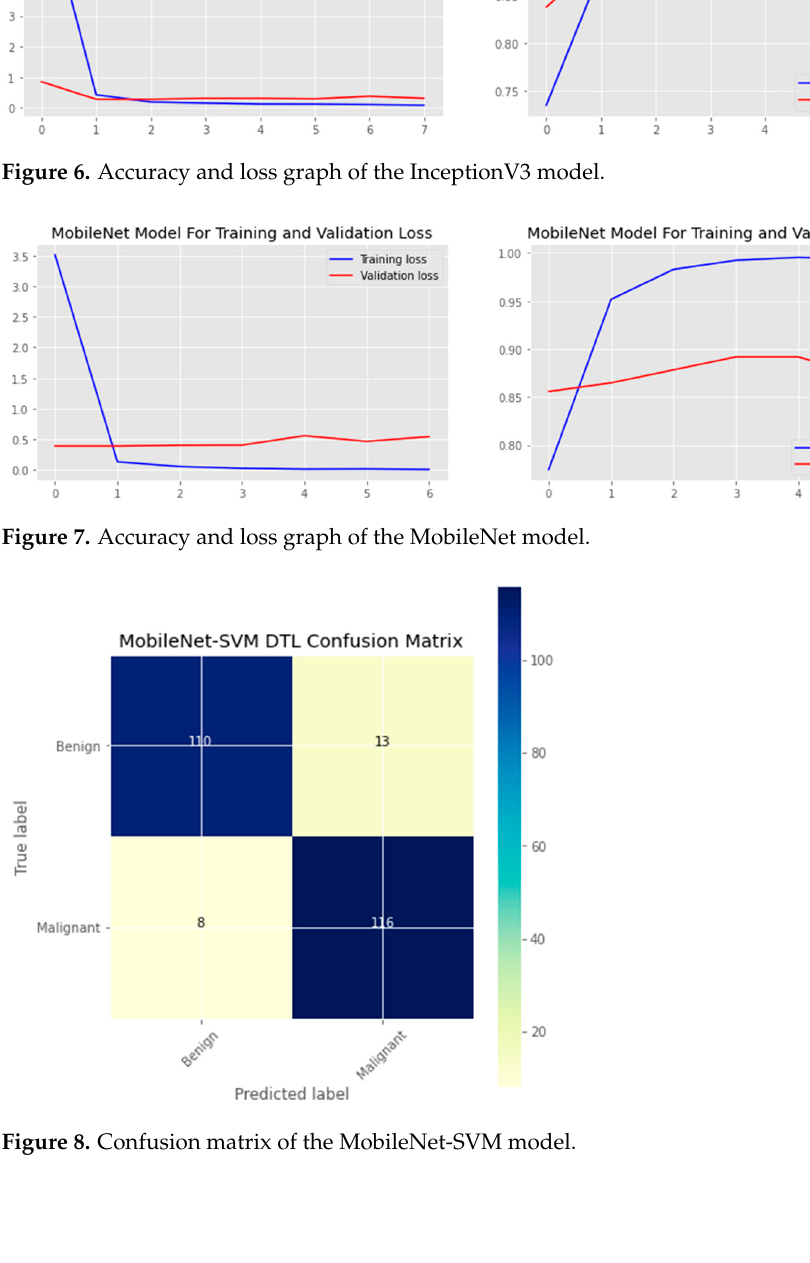
Figure 9. Confusion matrix of the DenseNet121 model.